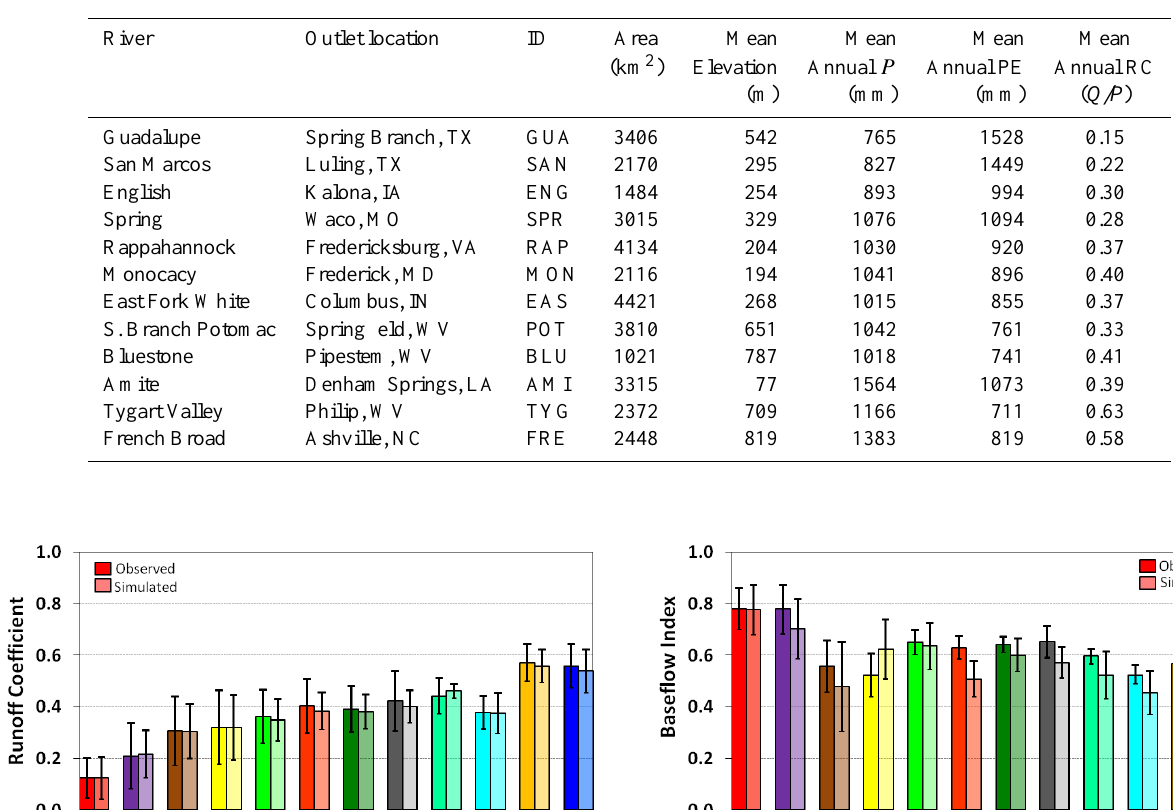
Table 1. Watershed characteristics.